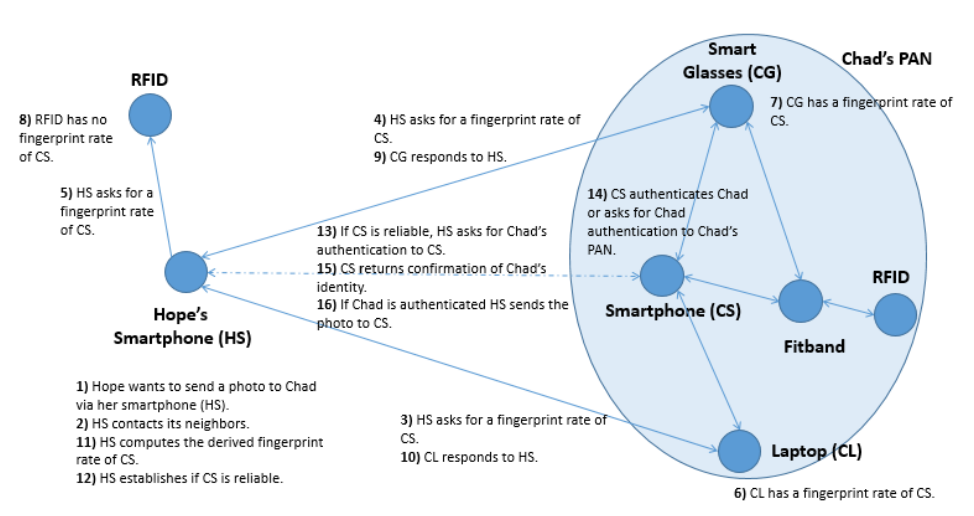
Figure 3. The steps of our approach for a human-to-human